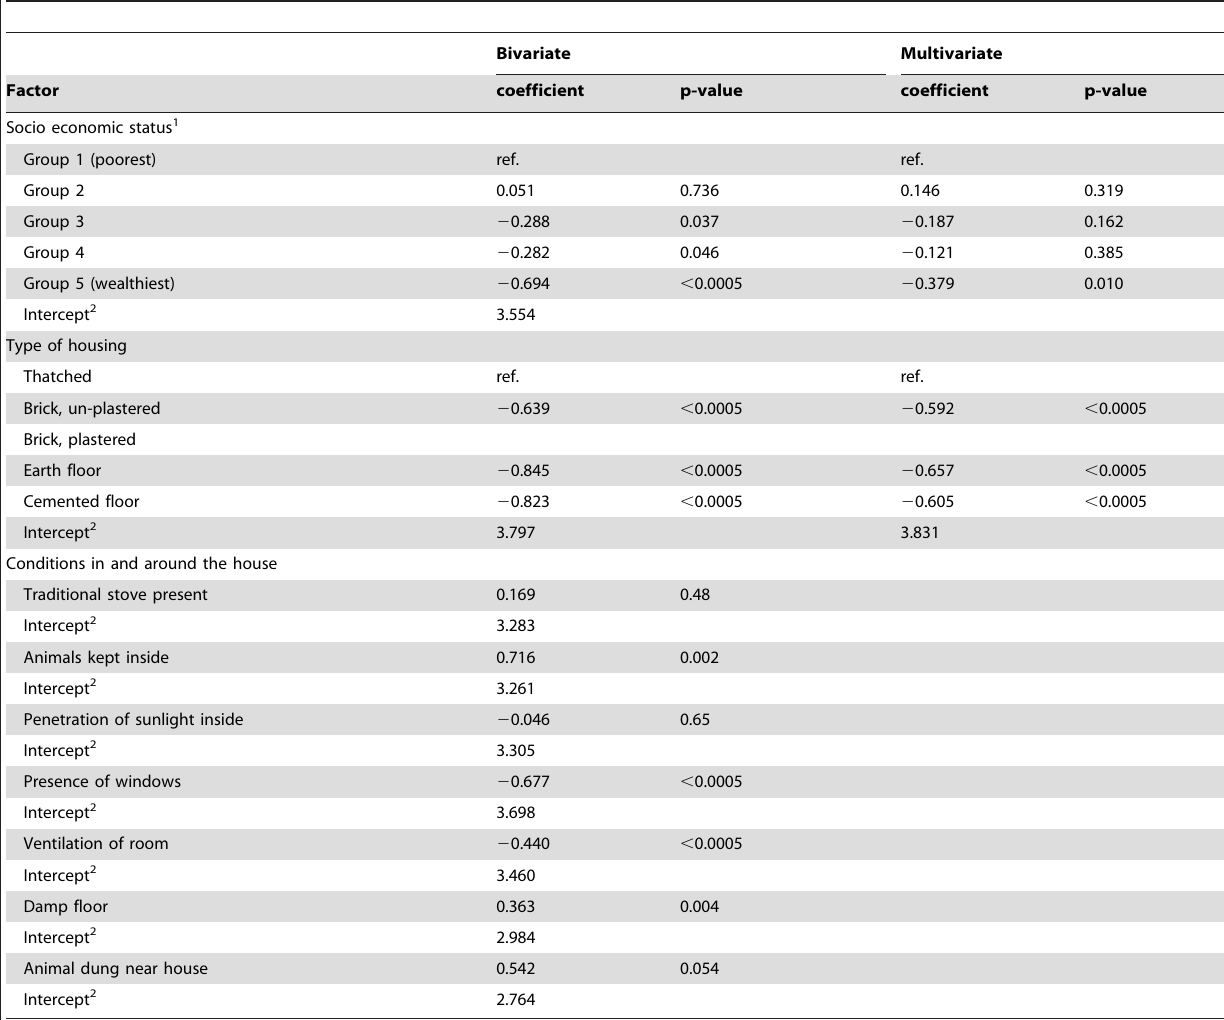
Table 3. Factors associated with Phlebotomus argentipes indoor density, results of linear mixed effect regression models with village as random effect.